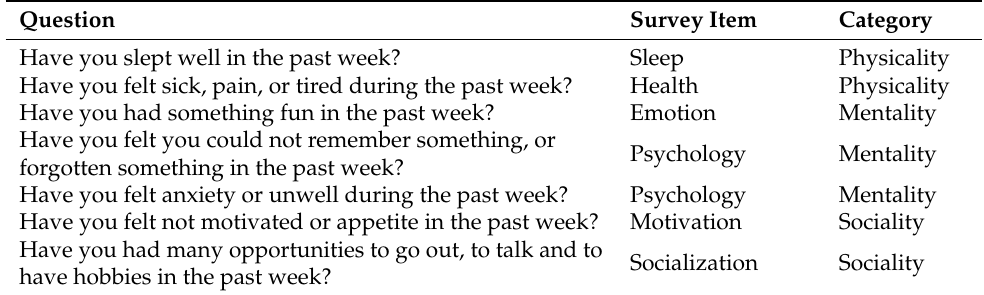
Table 1. Seven questions for capturing the health state from physical, mental, and social well-being. Question Survey Item Category Sleep Physicality Health